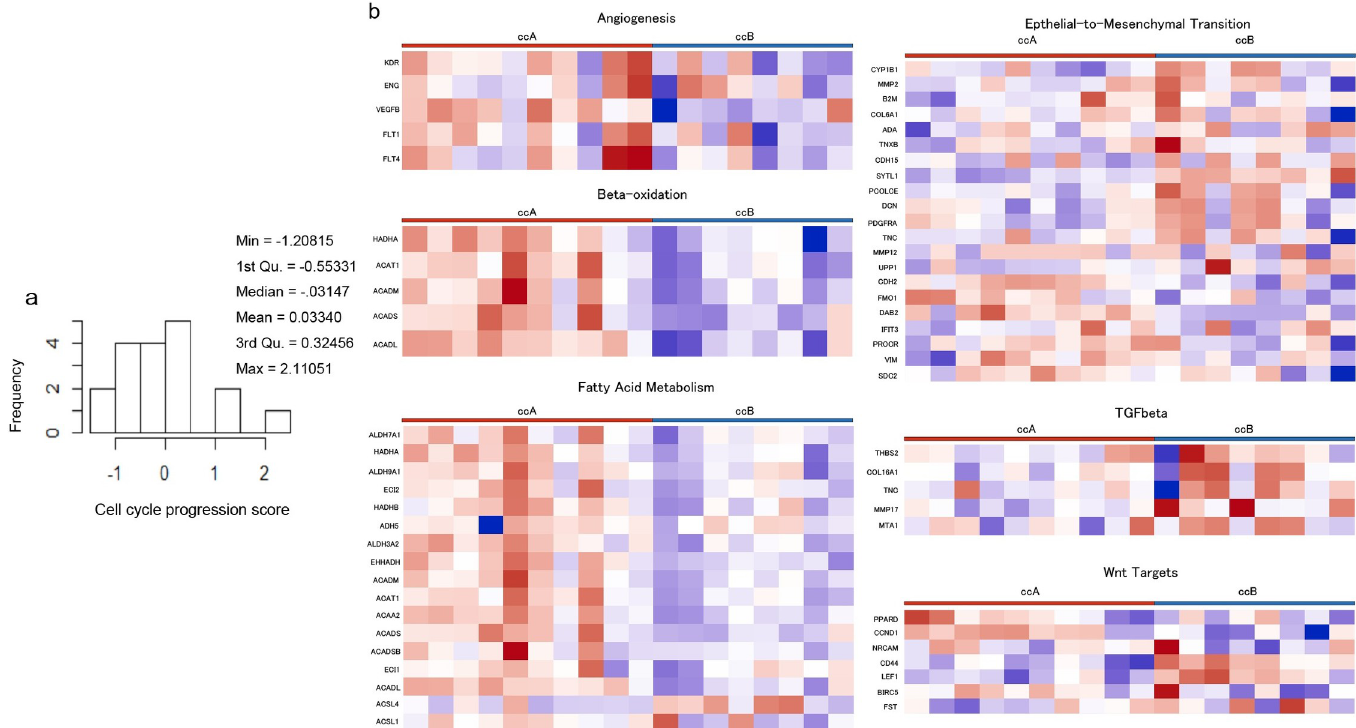
Fig 2. Tendencies in the transcriptome profiling. a : Distribution of all CCP scores. b : Results of the pathway analysis of subtypes showing that the ccA and ccB tumors are highly dissimilar, as previously reported [20]. Magnified heat maps of the genes that populate the ccA or ccB groups overexpressed MSigDB (Molecular Signatures Database)-curated gene sets of Brentani angiogenesis, beta-oxidation, fatty acid metabolism, EMT up, TGF β C4 up, and Wnt targets.